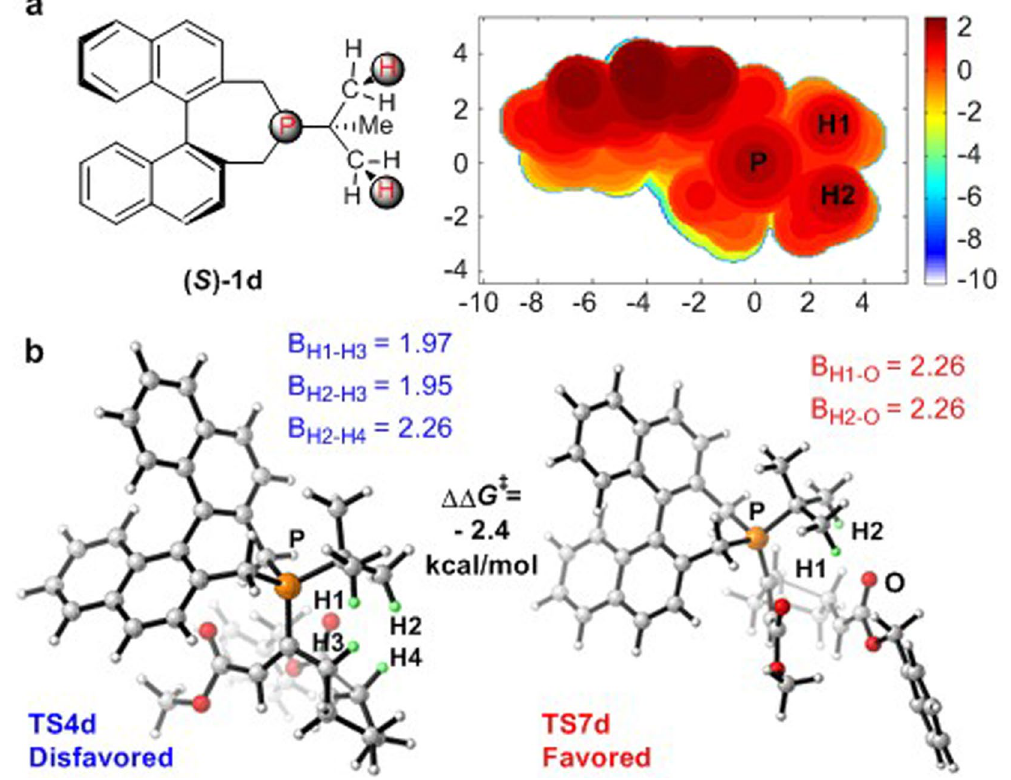
Figure 12. ( a ) 2D contour map of the Van der Waals surface of ligand ( S )-1d . Distances are given in angstroms. P atom is located at the origin of the coordinate system in the contour map. The contour line of zero is defined as in the same plane of the P atom. Negative distance (blue) indicates that the atoms on the ligand are farther away from the substrate; positive distance (red) indicates that the atoms on the ligand are closer to the substrate. ( b ) Geometries of transition states TS-4d and TS-7d with catalyst ( S )-1d . The values of bond lengths are given in